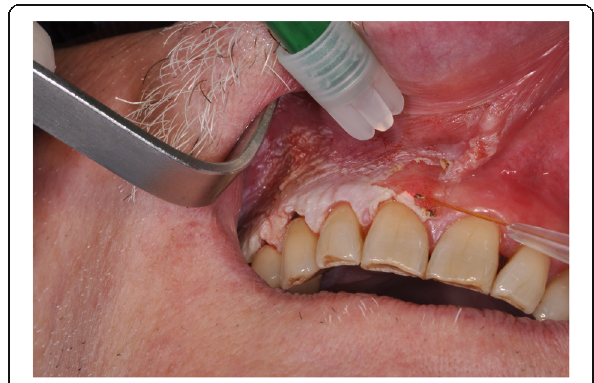
Fig. 4 Surgical excision of the verrucous leukoplakia by a diode laser. Note the complete absence of hemorrhage